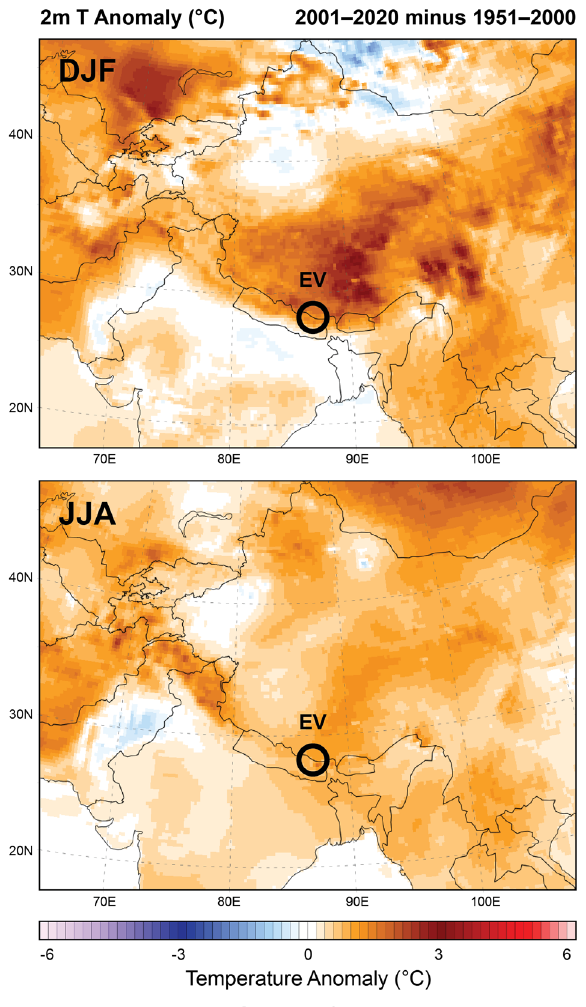
Fig. 2 Temperature anomaly. Annual 2-meter temperature anom- aly maps for a December – February (DJF) and b July – August (JJA). The anomaly values are for the period 2001 – 2020 minus 1951 – 2000 climatology. The location of Mt. Everest is circled and labeled “ EV ” . Data from the European Centre for Medium-Range Weather Forecasts (ECMWF) ERA-5 reanalysis (ERA5) 19 . Maps generated using Climate Reanalyzer 33 .